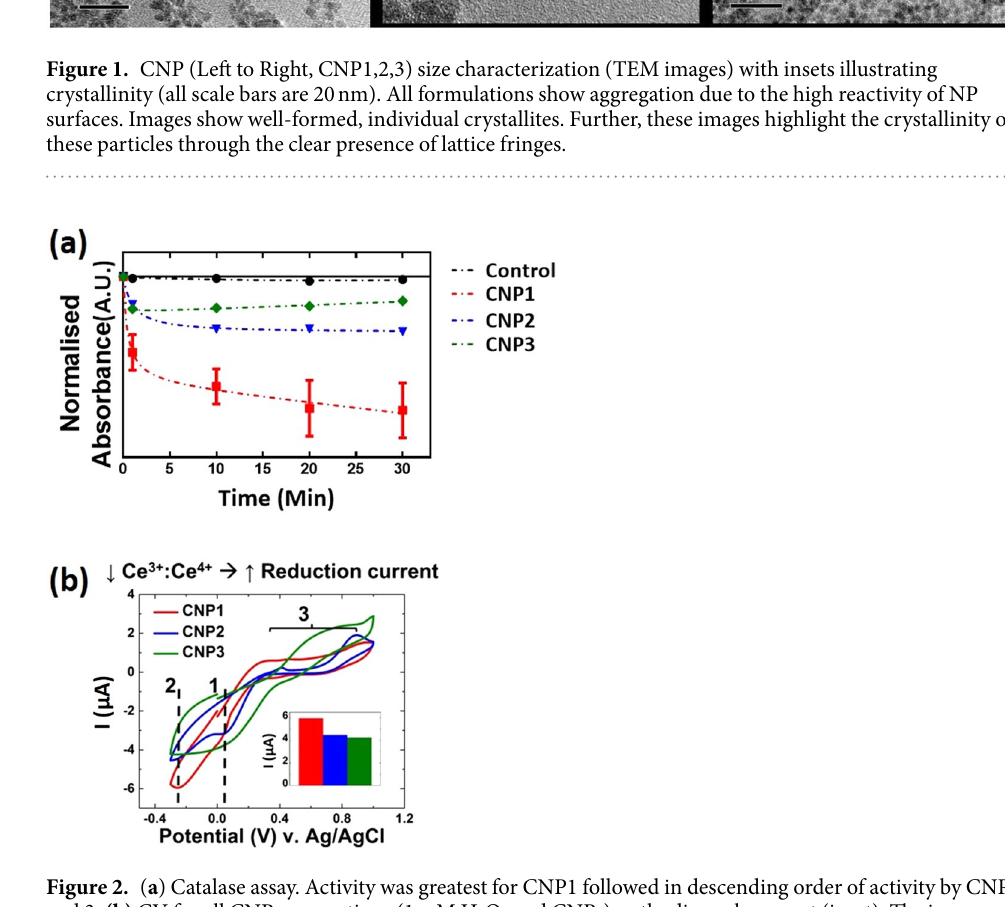
Figure 2. ( a ) Catalase assay. Activity was greatest for CNP1 followed in descending order of activity by CNP2 and 3. (b) CV for all CNP preparations (1 mM H 2 O 2 and CNPs), cathodic peak current (inset). The inverse relationship between Ce 3 + :Ce 4 + ratio and catalase activity holds for CV. Additionally, an anodic peak present for all formulations shows a positive relationship between Ce 3 + :Ce 4 + ratio and